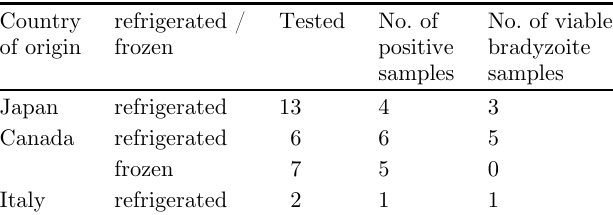
Table 1. Detection of Sarcocystis fayeri from